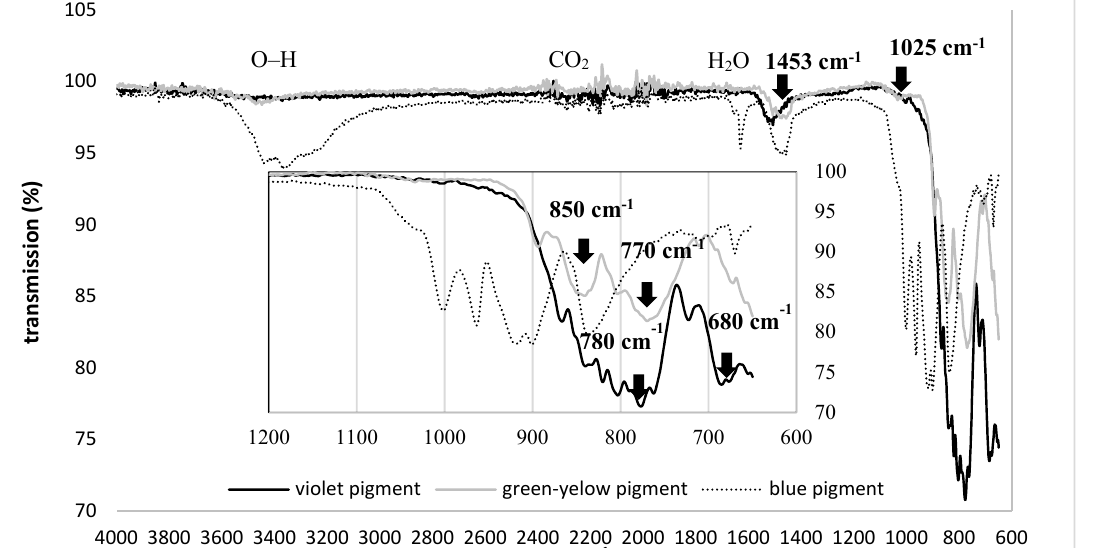
Figure 2. Fourier Transform Infrared (FTIR) spectral lines of violet, blue and yellow-green luminescent pigment powders.